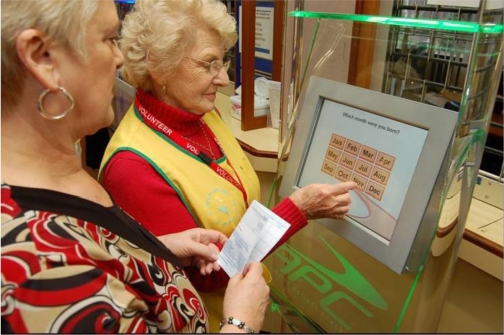
E-reception at Sherwood Forest Hospitals [109].